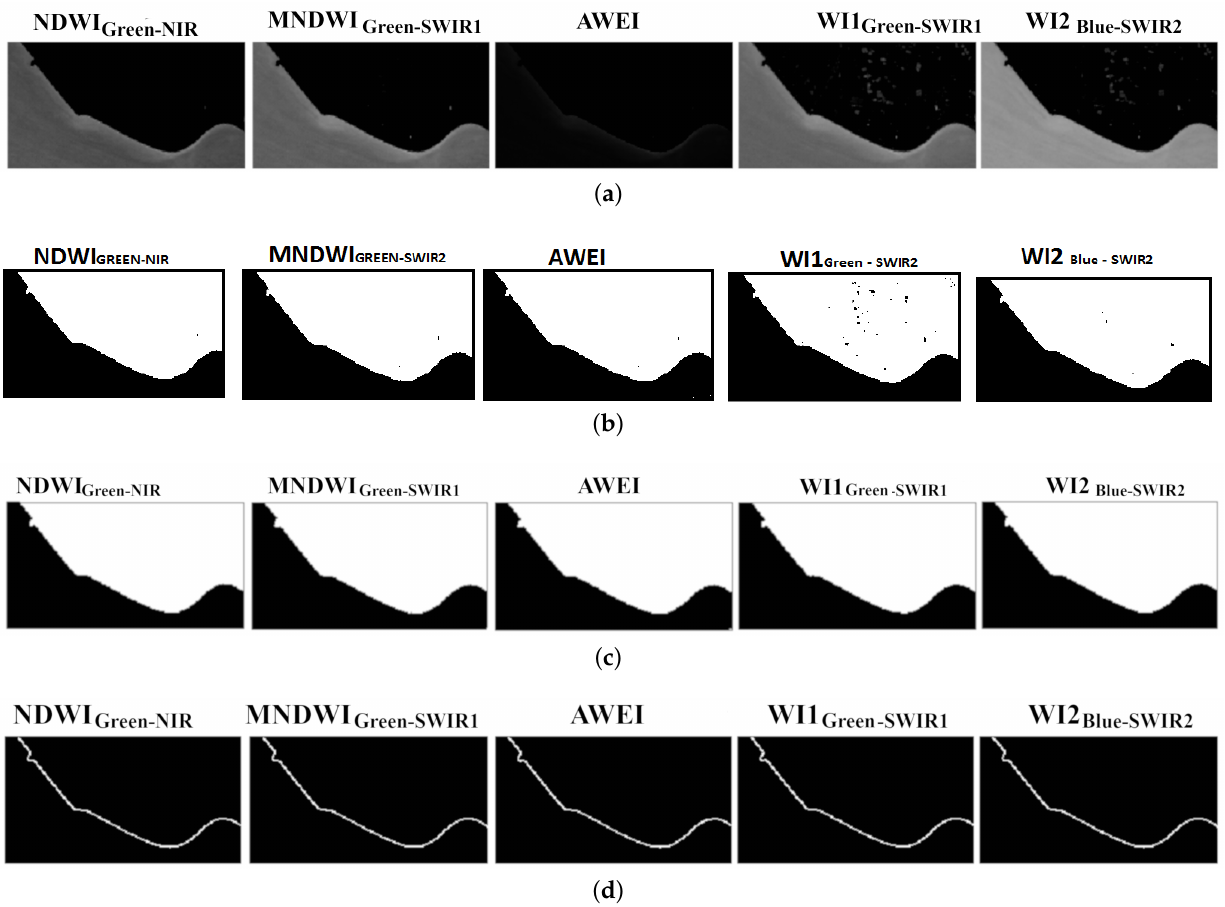
Figure 6. Sequence of the methodology for coastline detection on an OLI image from 12 September 2013. ( a ) An image after applying the water indexes for comparison. ( b ) The result of the segmentation process by Otsu’s Method: the image became binary where the black pixels correspond to water and the white pixels correspond to a non-water area. ( c ) The binary image after the application of morphological operation to finally delineate the coastline ( d ) after the automatic algorithm is